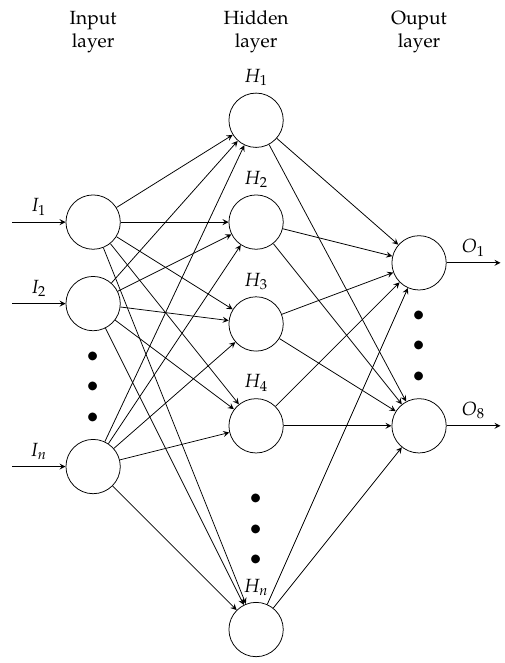
Figure 10. Artificial neural network